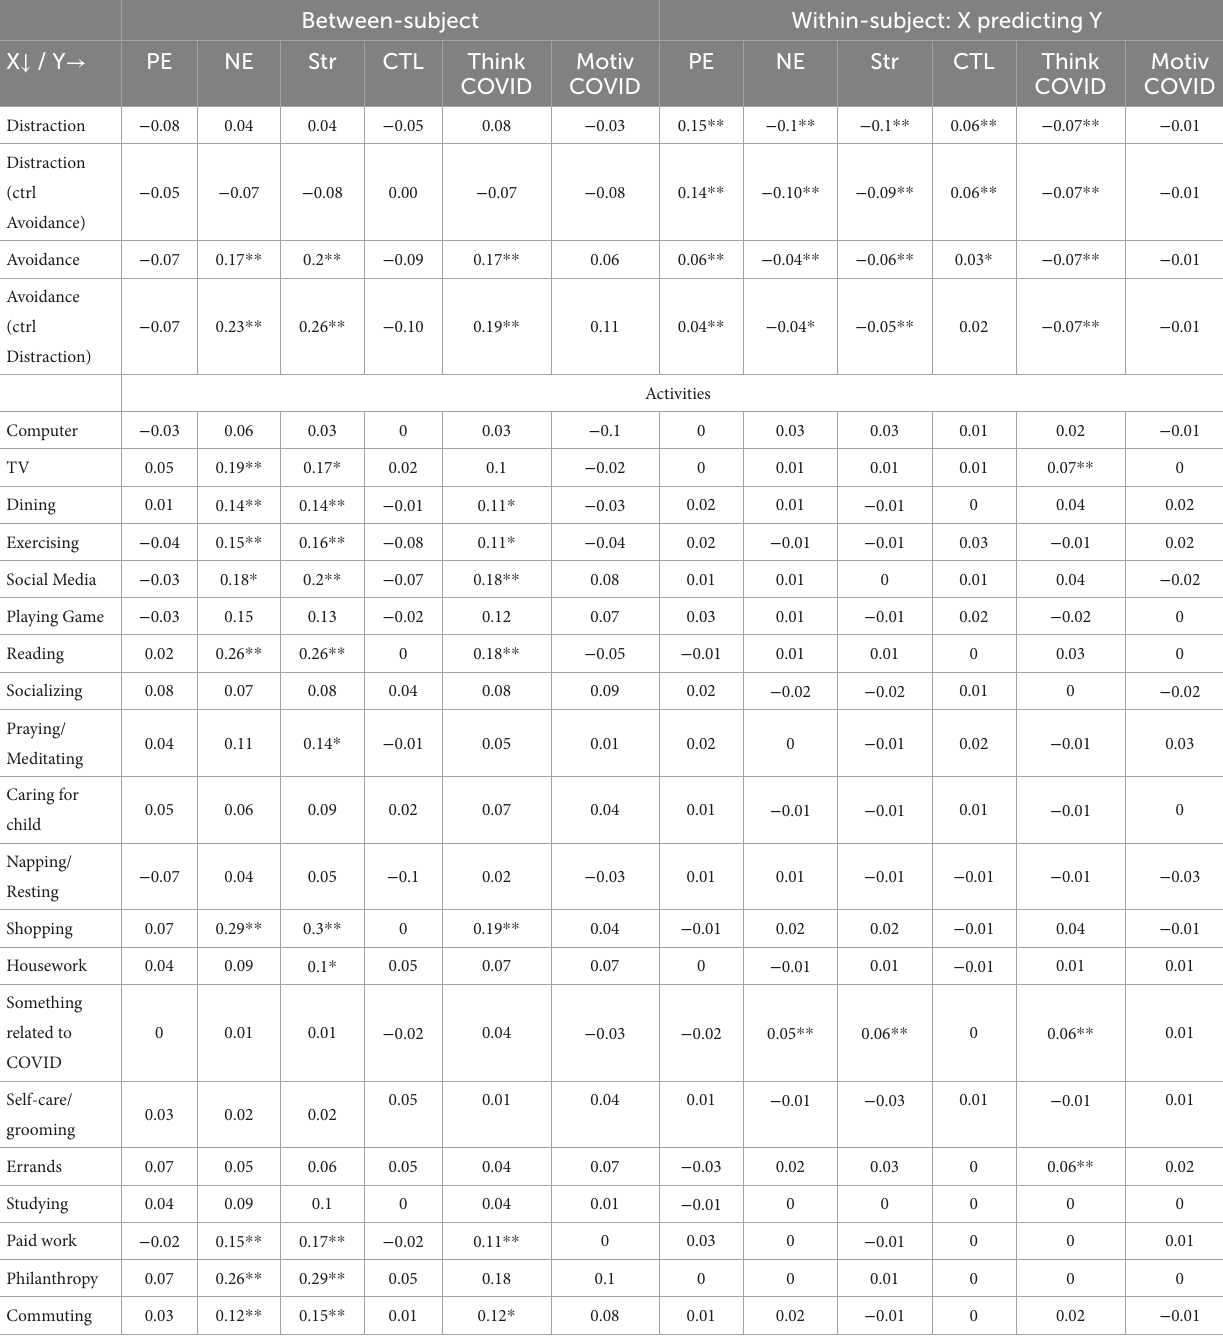
TABLE 1 Multilevel models of the relationship between distraction, avoidance, activities and emotional responses during daily diary